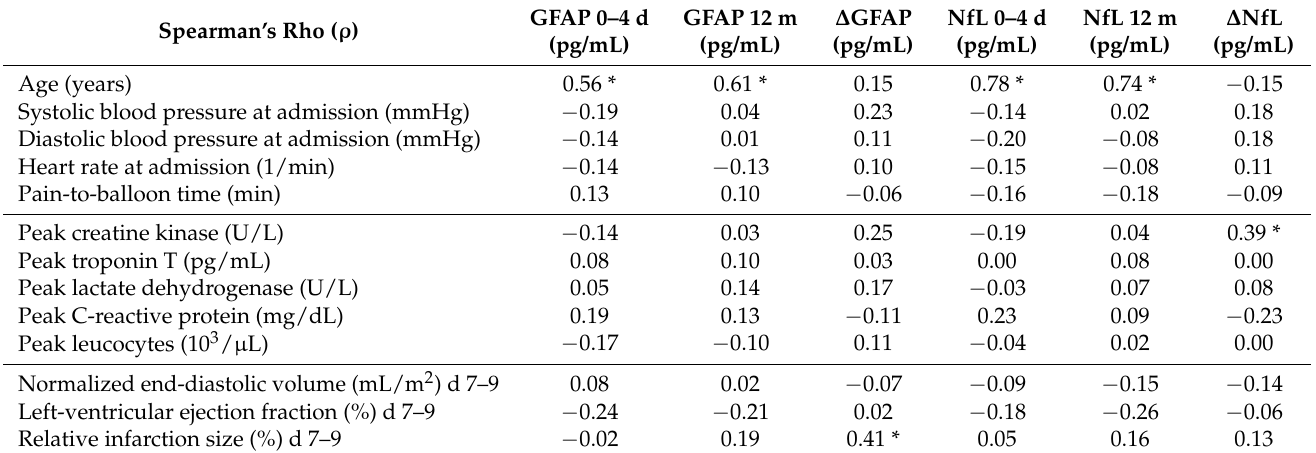
Table 2. Spearman’s correlation of clinical, laboratory, and cMRI parameters with NfL and GFAP serum levels. * = p <